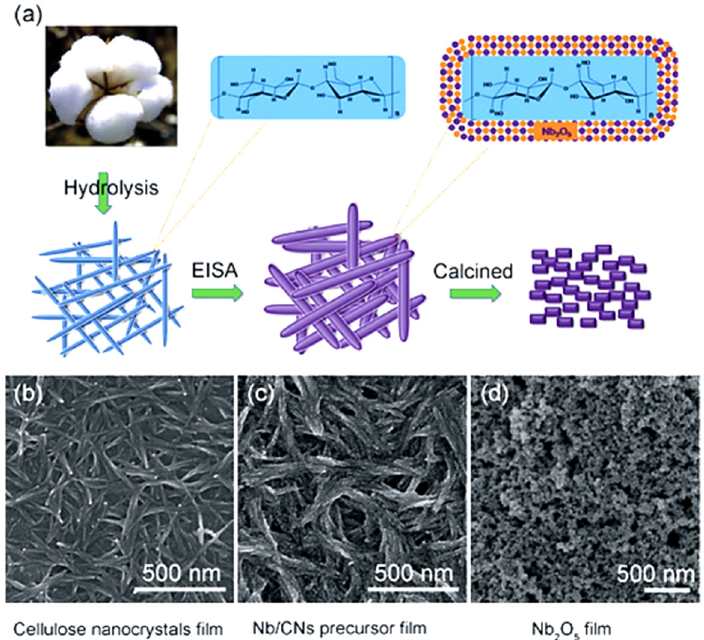
Figure 12. The schematic presentation of the Nb 2 O 5 nanostructures prepared by an evaporation- induced self-assembly process directed by CNCs ( a ), the SEM micrographs of the CN film ( b ), the CN/NbCl 5 composite film ( c ), and the mesoporous film of Nb 2 O 5 after calcination ( d ). Reprinted from [ 253 ] . Copyright 2014, with permission from Elsevier B.V.